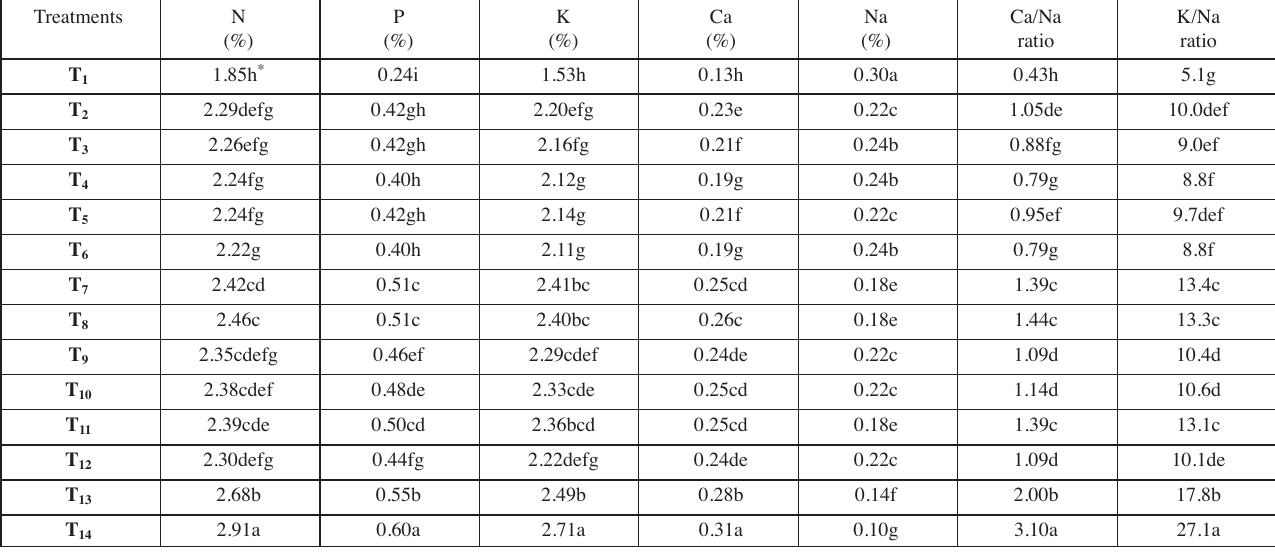
Tab. 4: Effect of N-fertilizer form applications on the contents of various elements [nitrogen (N), phosphorus (P), potassium (K), calcium (Ca), and sodium (Na)] and the ratios of Ca:Na and K:Na in shoots of wheat plants grown under saline soil conditions